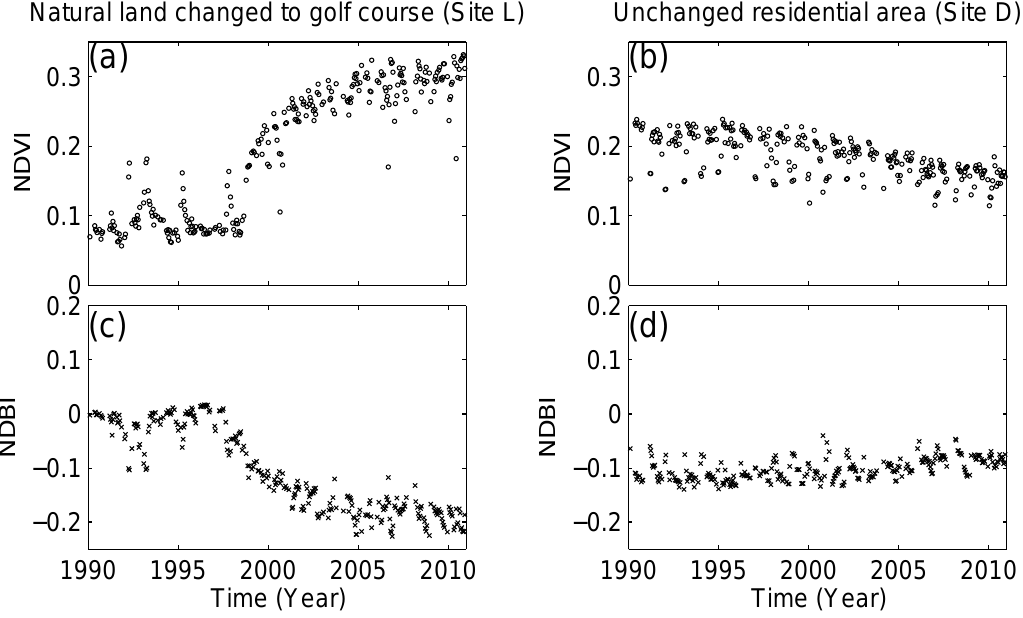
Figure 2. Trends of NDVI ( a , b ) and NDBI ( c , d ) at a new development site L ( a , c ) and older development site D ( b , d